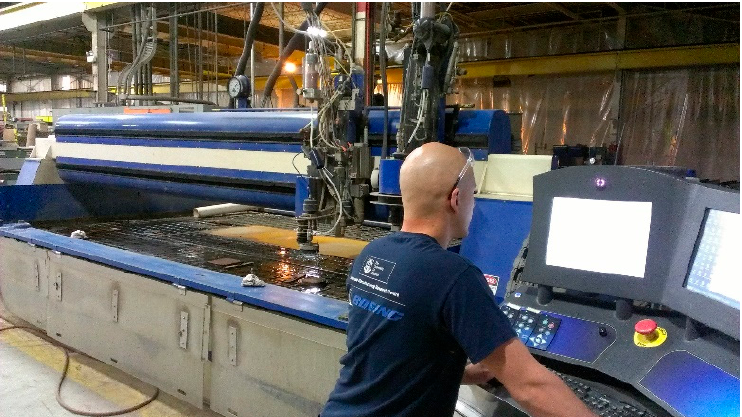
Figure 3. Ward Jet technician checking file. Notice the large basin of water under the nozzle. [Photo by Author].